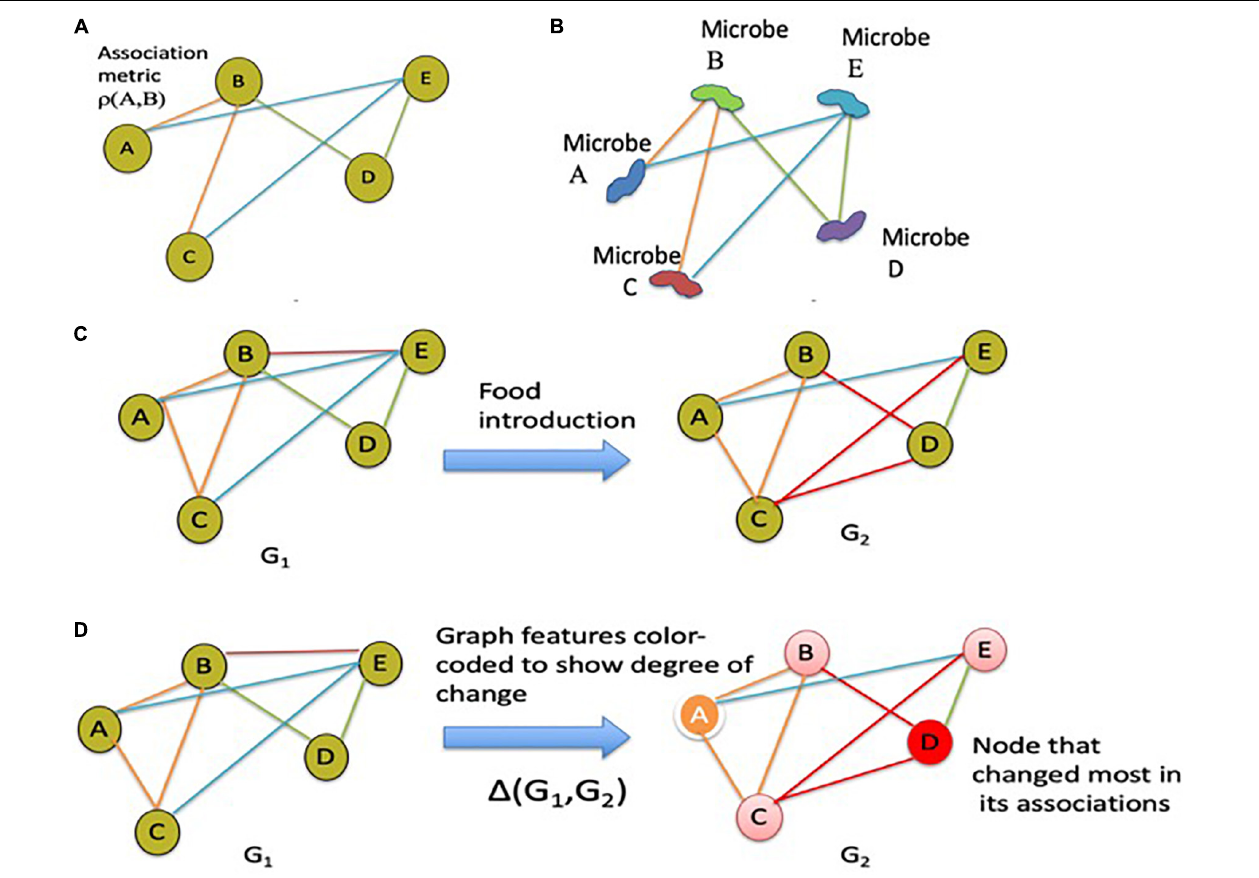
FIGURE 4 | Association graphs demonstrating microbial co-occurrence networks and microbial composition changes over time. These association graphs can be included into metacommunity models such as the one in Figure 1 . (A) Schematic diagram of an association graph. (B) Schematic microbial co-occurrence network based on the association graph shown in panel A . (C) Schematic showing the changes in gut microbiota associations within an individual in response to the introduction of food; other external stressors can be considered equivalently. (D) Variation of the schematic shown in panel C with color-coding to show the degree of change at each